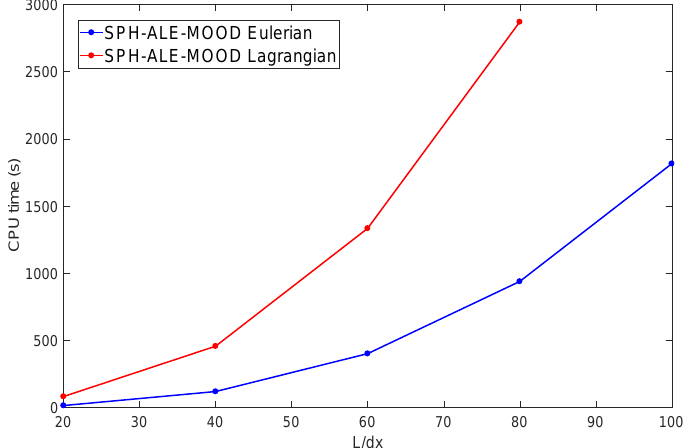
Figure 14. Taylor Green flow: Computational costs for different particle discretization.